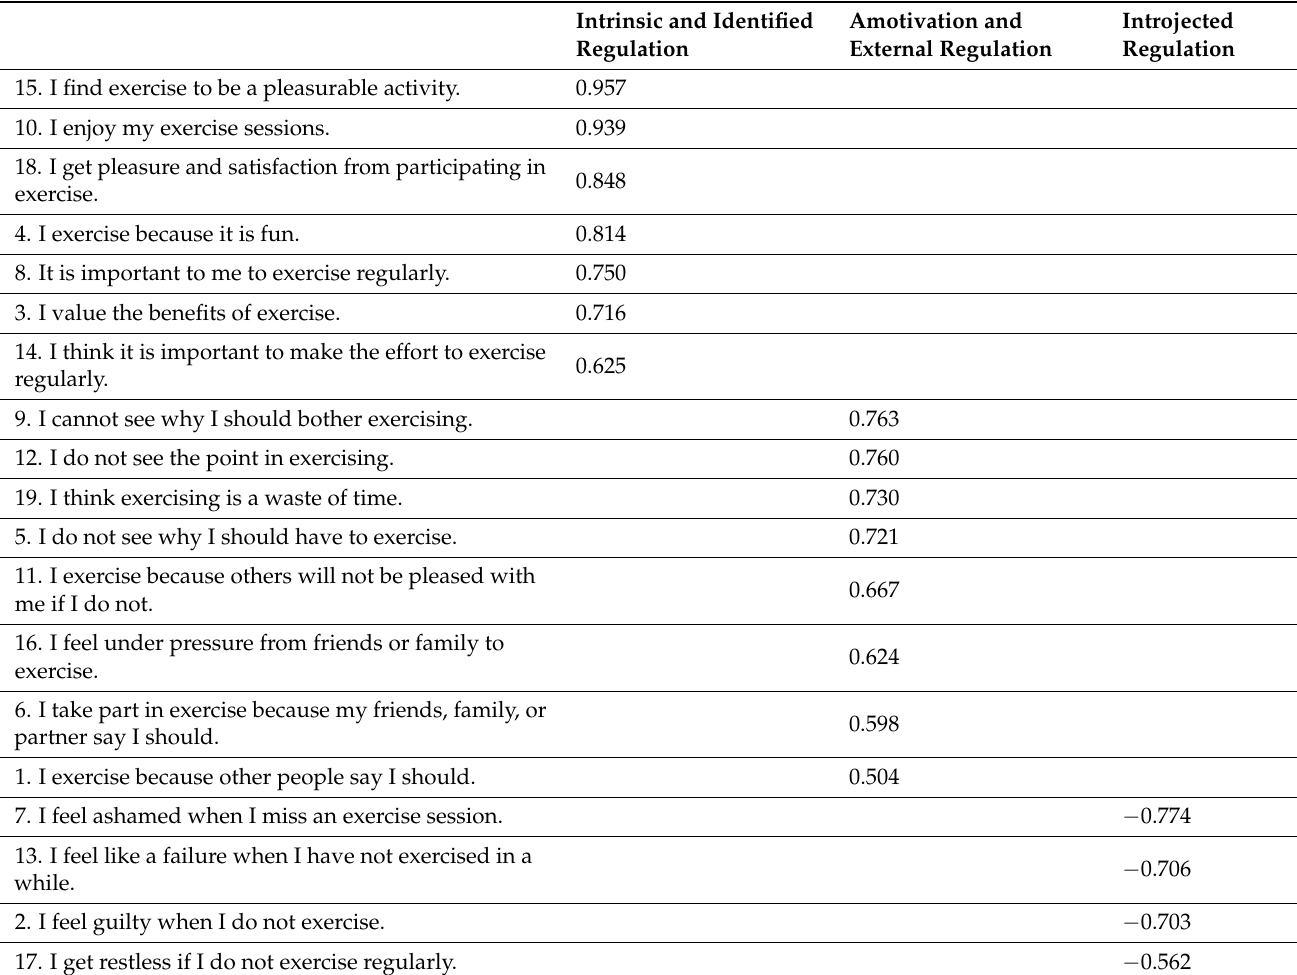
Table A2. The factors of behavioral regulation of exercise, based on the BREQ-2 (Soruce: PERSIST 2019, N = 2005).